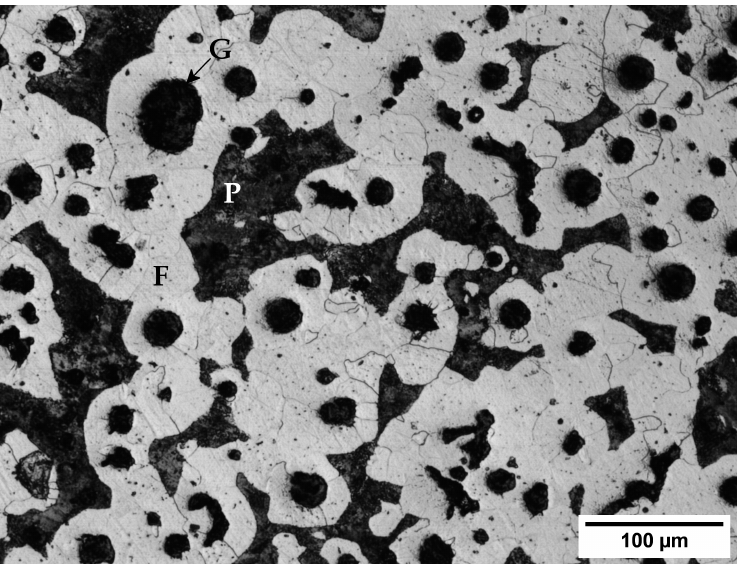
Figure 1. Microstructure of the alloy before any heat treatment. G: Graphite; F: Ferrite; P: